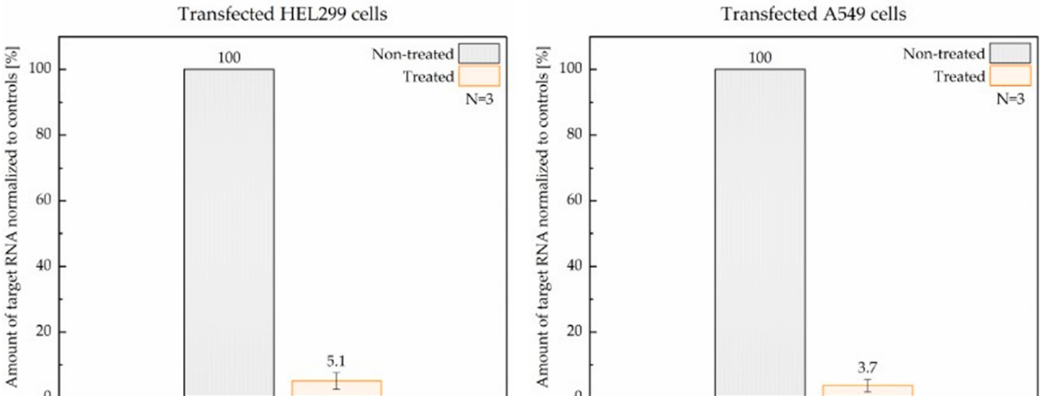
Figure 4. Reduction in RdRp RNA levels upon treatment with ASC1R in transfected HEL299 ( left ) and A549 ( right ) cells assessed by RT ‐ qPCR. Non ‐ treated parallels served as controls. Transfection and treatment of cells were repeated three times.